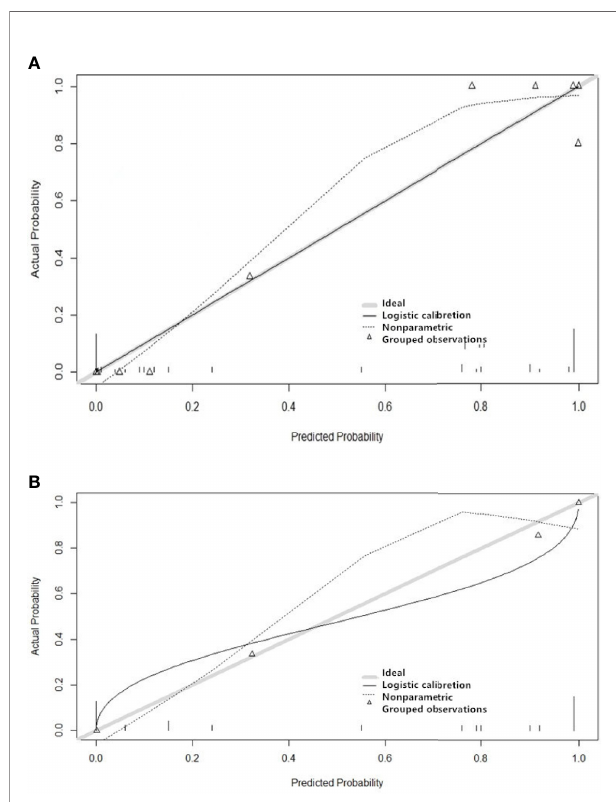
FIGURE 5 | Performance of the four imaging models for predicting the recurrence of grade II gliomas. The y-axis represents the actual probability, and the x-axis represents the predicted probability. Figure (A) shows the model ’ s calibration of the training set, and Figure (B) shows the validation set. A calibration curve describes the consistency between the predicted and actual tumor recurrence rate. The 45° gray heavy lines represent the ideal prediction performance, the non-45dotted lines represent the prediction performance of the model, and non-45° solid lines represent the corrected prediction performance of the model. The closer the solid line is to the ideal gray line, the better the prediction accuracy of the